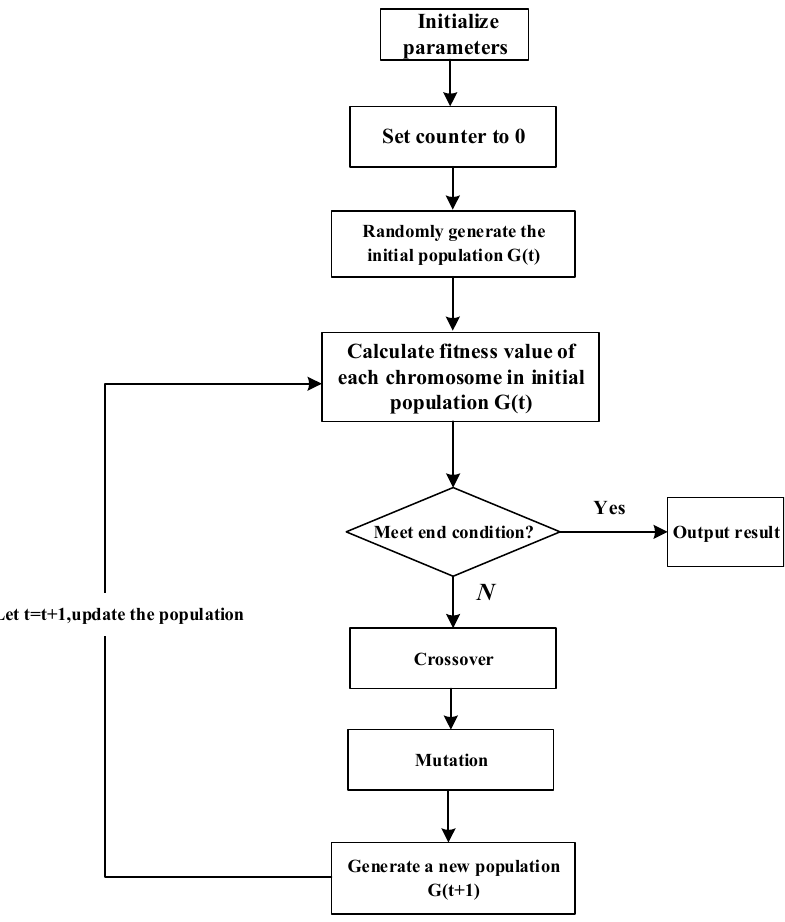
Figure 6. Process of model solution through genetic algorithm.